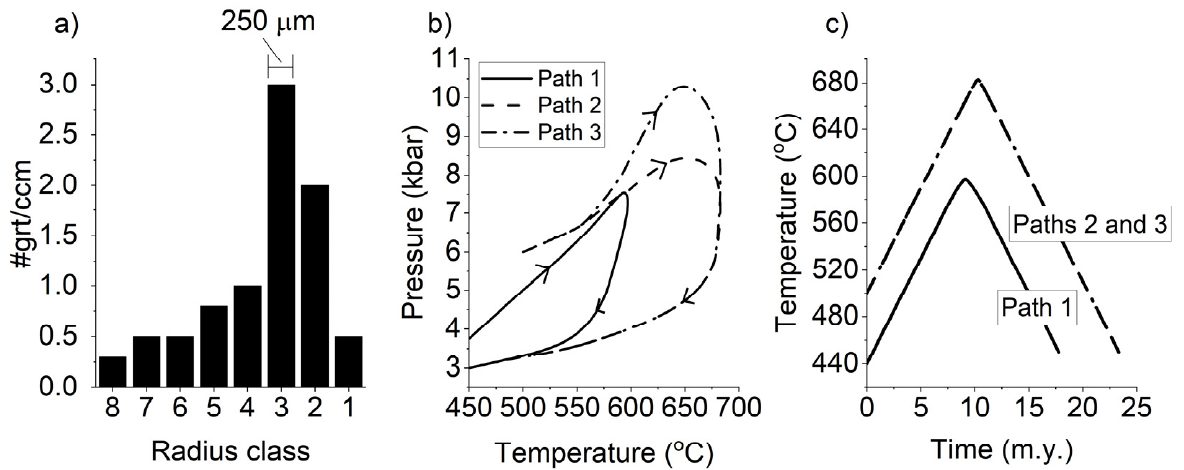
Figure 4. Specified P-T-t trajectories for Theria_G simulations executed using average bulk rock compositions from the Menderes Massif (Turkey) Bayındır and Bozda˘g nappes. ( a ) Specified crystal size distribution (CSD), based upon petrographic observations. ( b ) Pressure-temperature paths specified for Theria_G simulations. The trajectories are based upon previous P-T estimates made throughout the region, and also consider field observations. ( c ) Temperature-time histories for P-T paths to show specified heating/cooling rates.